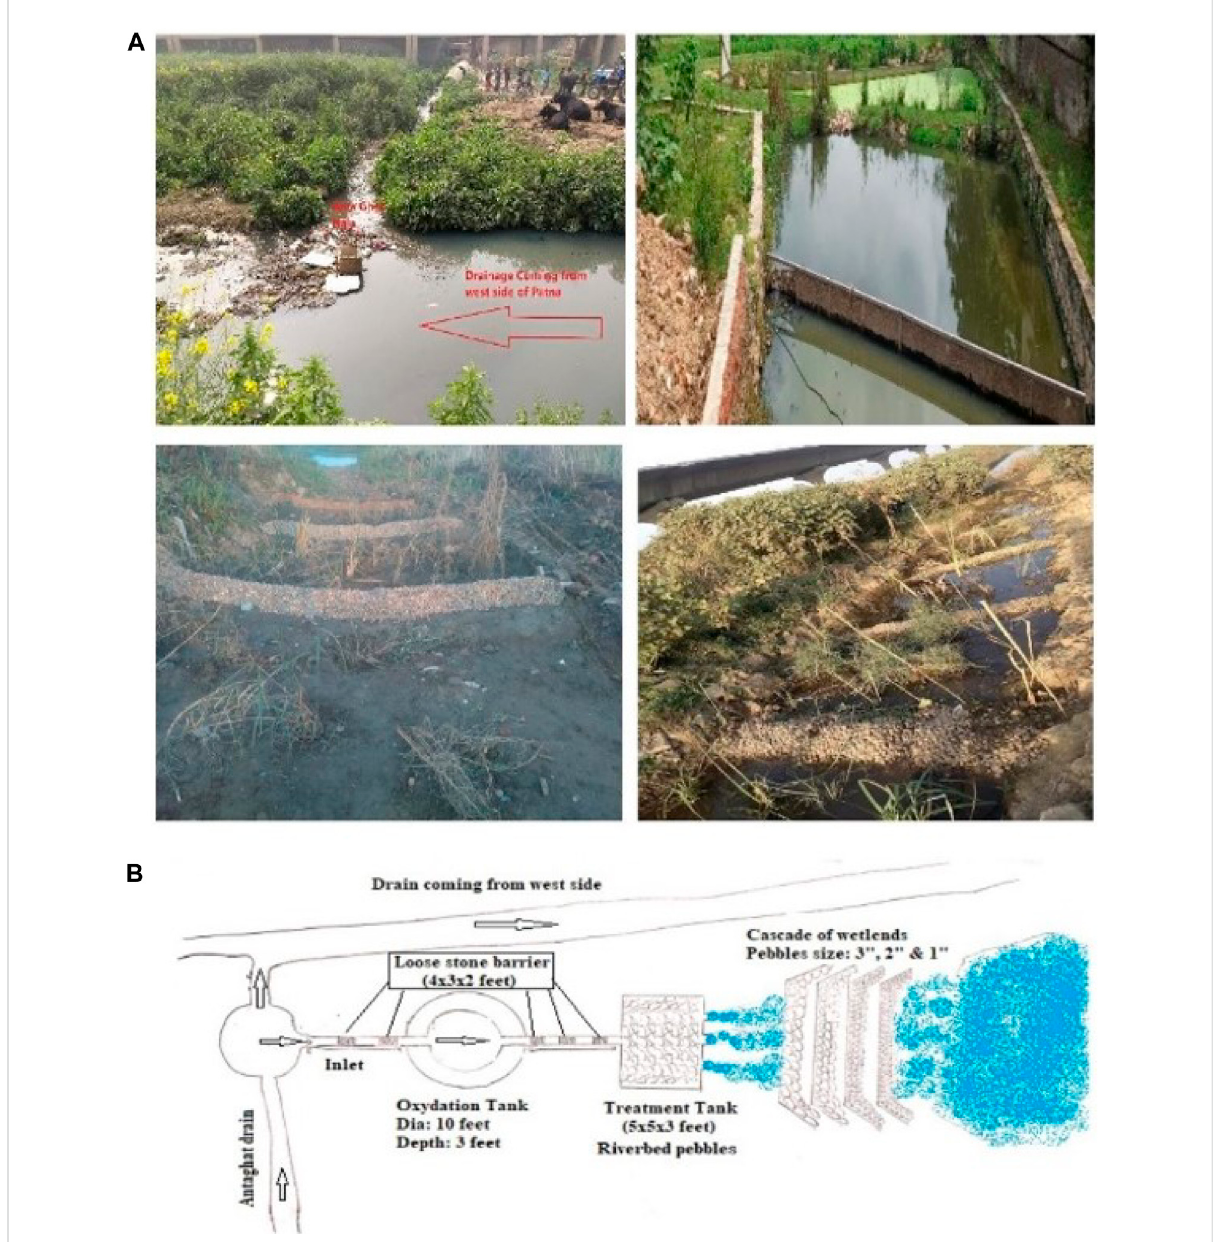
FIGURE 3 Photograph of CWS, (A) Photograph of CWS, showing inlet, outlet and stages during plantation; (B) schematic presentation of media in treatment bed and Morphometric details with ridges and riverbed pebbles used at Antaghat wastewater discharge site at the southern bank of the River Ganges at Patna,